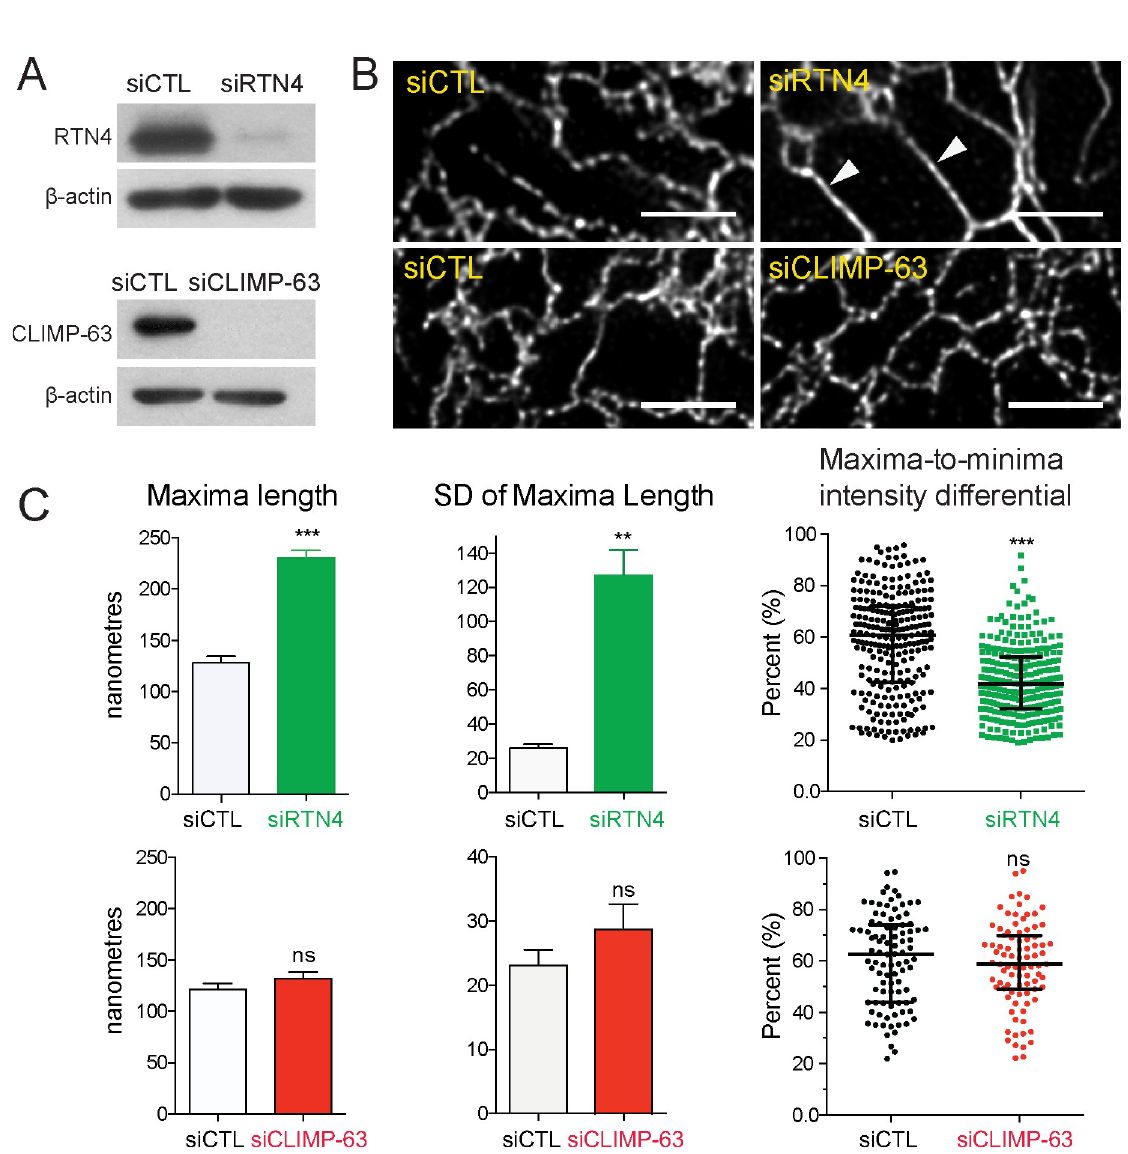
Fig 2. RTN4 regulates lumenal ER nanodomain periodicity. (A) Western blots of siCTL–, siRTN4–, and siCLIMP-63–transfected HT- 1080 cells were probed with anti-RTN4, anti-CLIMP-63, and anti- β -actin as a loading control. (B) Representative images of ER tubules in HT-1080 cells transfected with ERmoxGFP and siCTL, siRTN4, or siCLIMP-63. Arrowheads indicate the tubules with increased blob length. Scale bar, 2 μ m. (C) The quantification of maxima length, variation of maxima length (SD), and maxima-minima intensity differentials of ER tubules in HT-1080 cells transfected with siRTN4, siCLIMP-63, or siCTL. Bar graphs show mean ± SEM and scatter dot plots median with interquartile range. Significance assessed by Student t test from three independent experiments (20–40 line scans/each repeat). �� P < 0.01; ��� P < 0.001. Numerical values that underlie the graphs and plots are shown in S1 Data. CLIMP-63, cytoskeleton- linking membrane protein 63; ER, endoplasmic reticulum; ERmoxGFP, ER monomeric oxidizing environment-optimized green fluorescent protein; ns, not significant; RTN4, reticulon4; SD, standard deviation; siCLIMP-63, siRNA to CLIMP-63; siCTL, siControl; siRTN4, siRNA to RTN4.